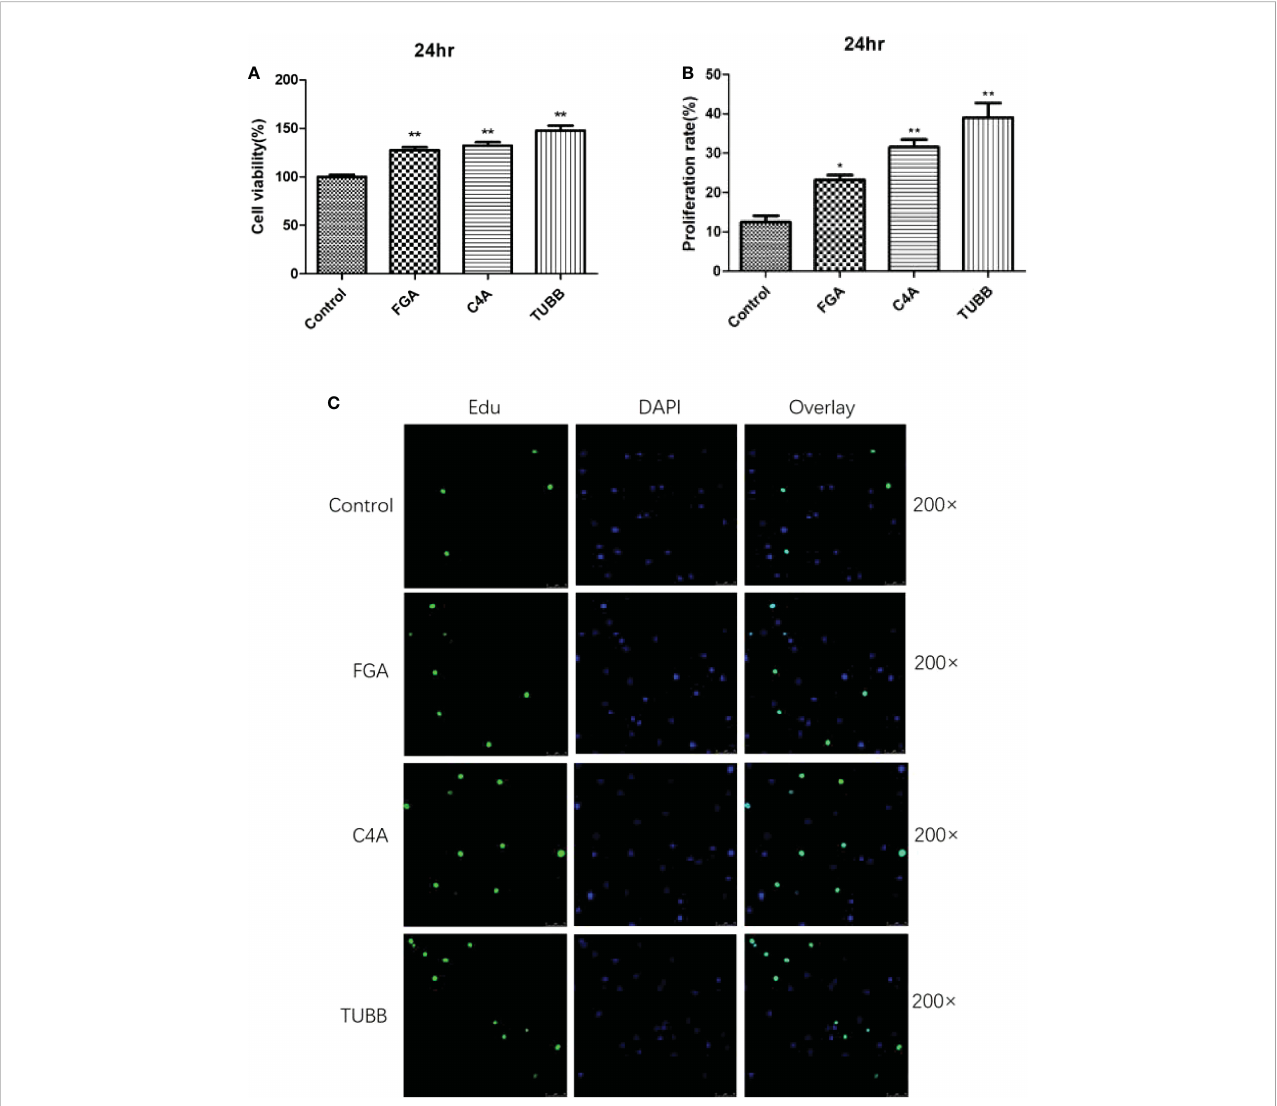
FIGURE 4 The results of Cell viability analysis veri fi cation by CCK8 and Edu staining: (A) The results of CCK8. (B) The results of Edu staining. (C) The 200x laser confocal microscope and photograph of Edu staining. * and ** indicates signi fi cant difference ( P < 0.05) and extremely signi fi cant difference ( P < 0.01) compared with the control